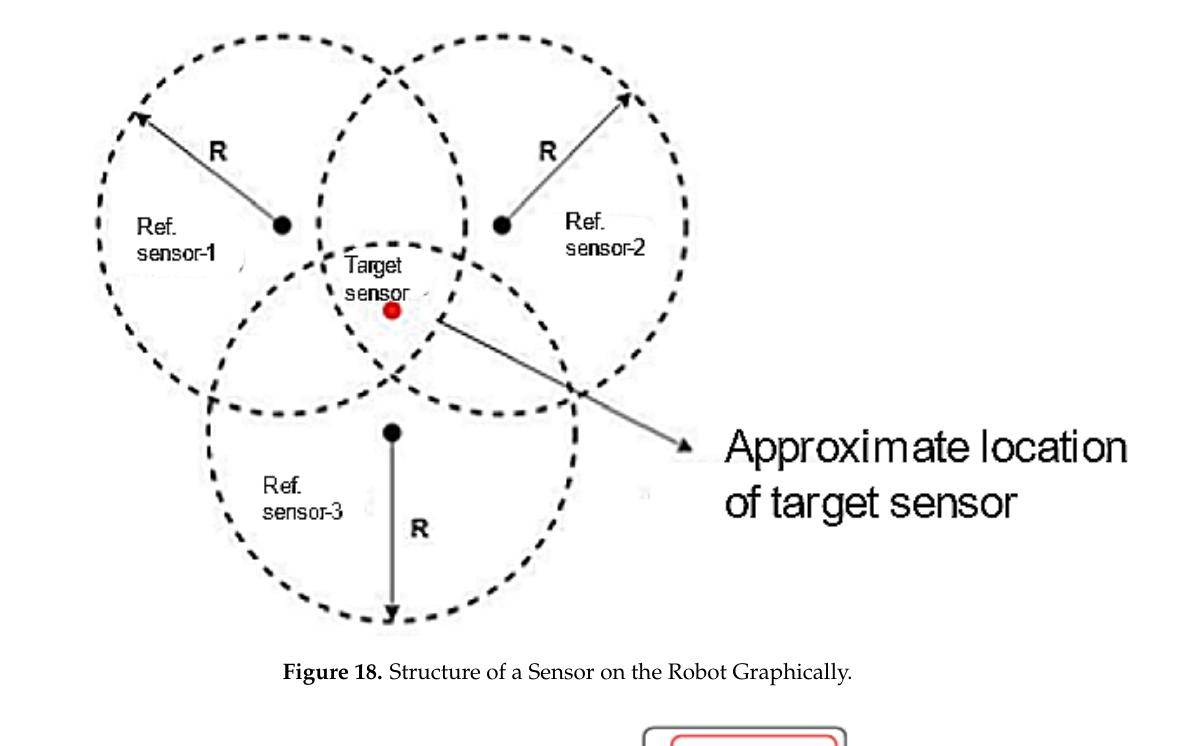
Figure 17. Sinograms of the Scanned Areas.